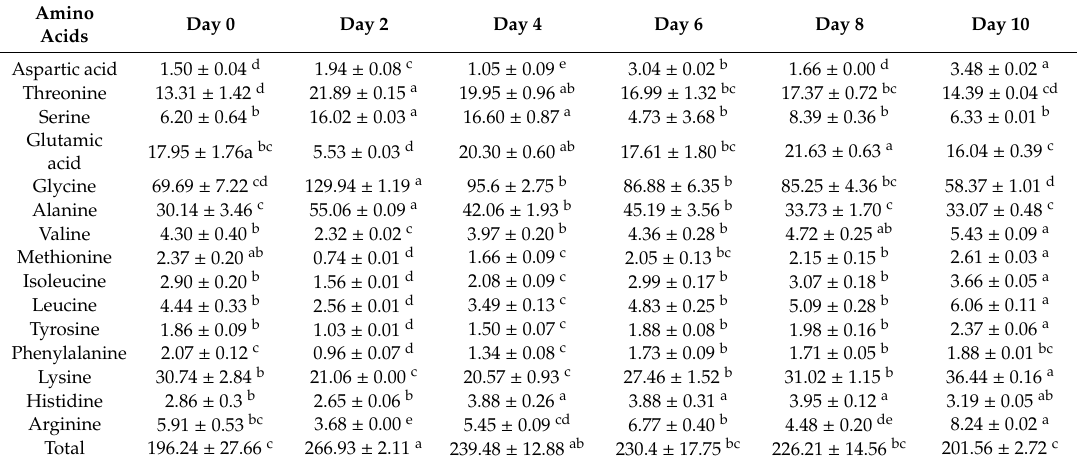
Table 2. Changes in the FAA contents (mg / 100g) of hybrid grouper fillets during storage at 4 ◦ C. Amino Day 0 Day 2 Day Acids